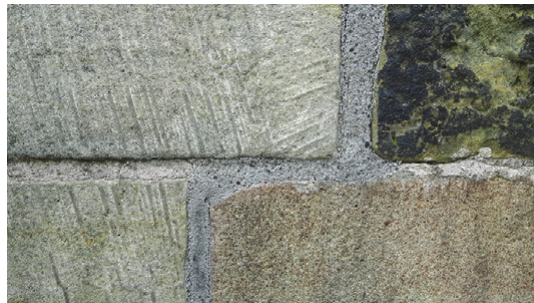
Fig. 5. Bridge cross section of the arch crown (A – electrical enclosure box, B – stone cover of electric cables, C – gas supply switch, D – rotatable bridge gully, E – cable raceway of the security camera system, F – gas supply in conduit, G – electric cables in conduit, H – layers of the bridge deck: granite paving – layer of sand solidified with lime – protective concrete layer – drainage mat – sprayed insulation – screed concrete – geotextile – reinforced concrete layer from previous reconstruction) (Tvrzník 2008)